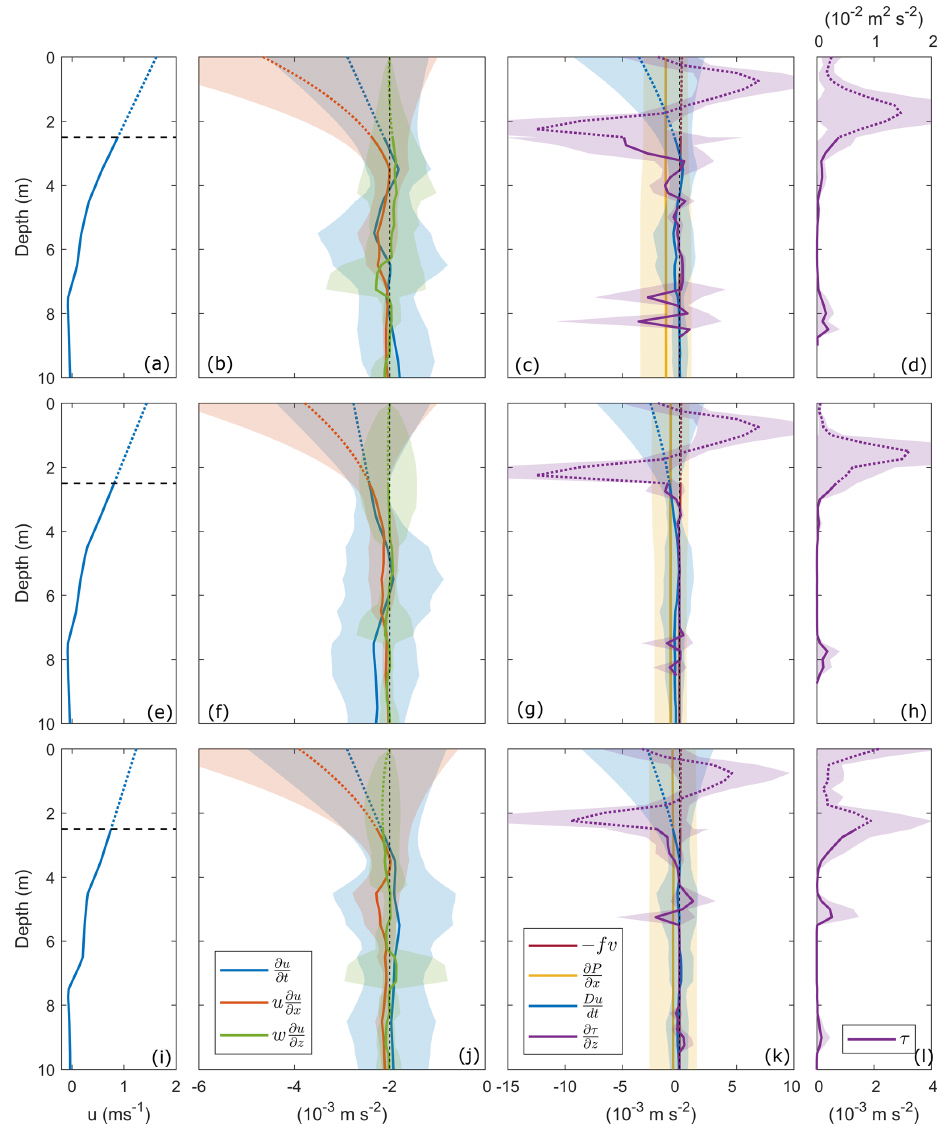
Figure 7. Terms in the along-channel momentum budget averaged over 0 ≤ x < 1km (a, b, c, d) , 1 ≤ x < 2km (e, f, g, h) and 2 ≤ x < 3km (i, j, k, l) . Profiles of (a, e, i) along-channel velocity u (dashed lines indicate depth over which velocity was interpolated to the surface), (b, f, j) local acceleration (blue) and advection ( x and z components, orange and green, respectively), (c, g, k) Coriolis force (red), pressure gradient (yellow), total acceleration (blue) and turbulence stress divergence (purple), and (d, h, l) internal turbulence stress ( τ , purple). The shading around each profile represents 1 standard deviation. The dotted profile above 2.5m for each term indicates the region over which each variable was calculated using interpolated velocity